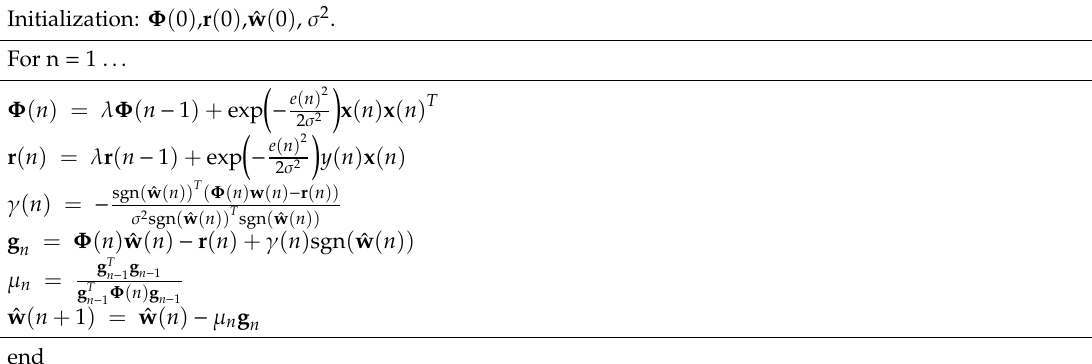
Table 1. Summary of the l 1 - iterative Wiener filter